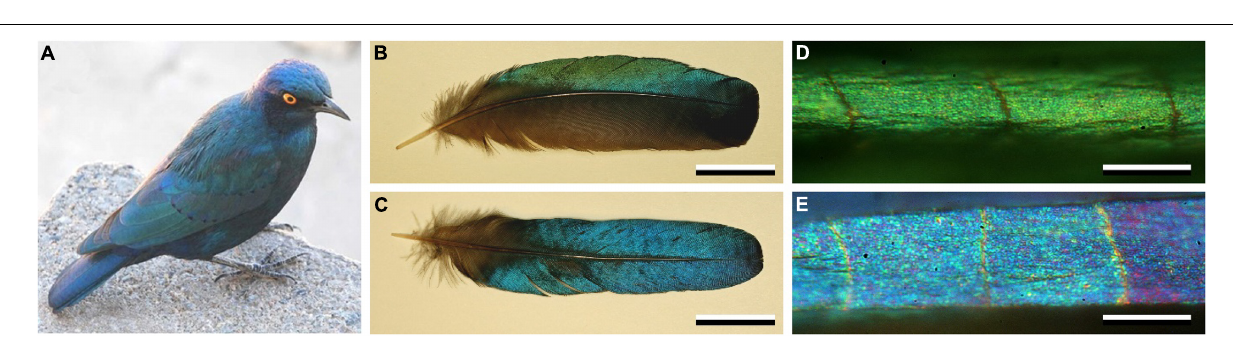
[ Figure 6A ; from Durrer and Villiger (1970)]. Scanning electron micrographs of cross-sections of the investigated L.